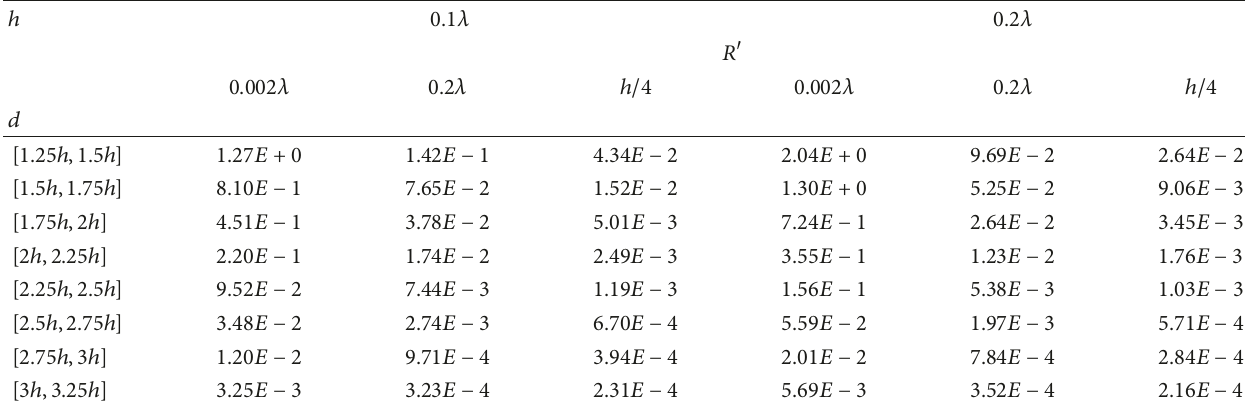
Table 1: RMSEs of the real parts of fitting Green’s